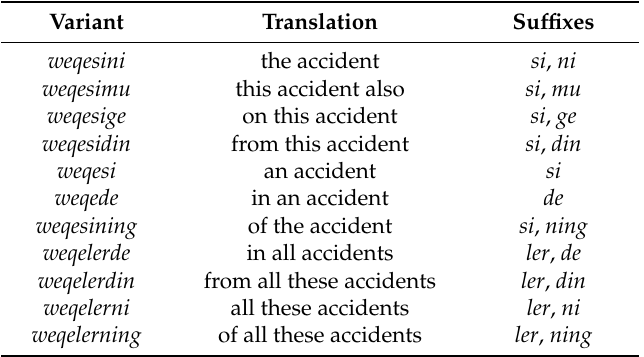
Table 1. Different variants of weqe (“accident,” “event,” or “incident”). Variant Translation Suffixes weqesini the accident si , ni weqesimu this accident also si , mu weqesige on this accident si ,